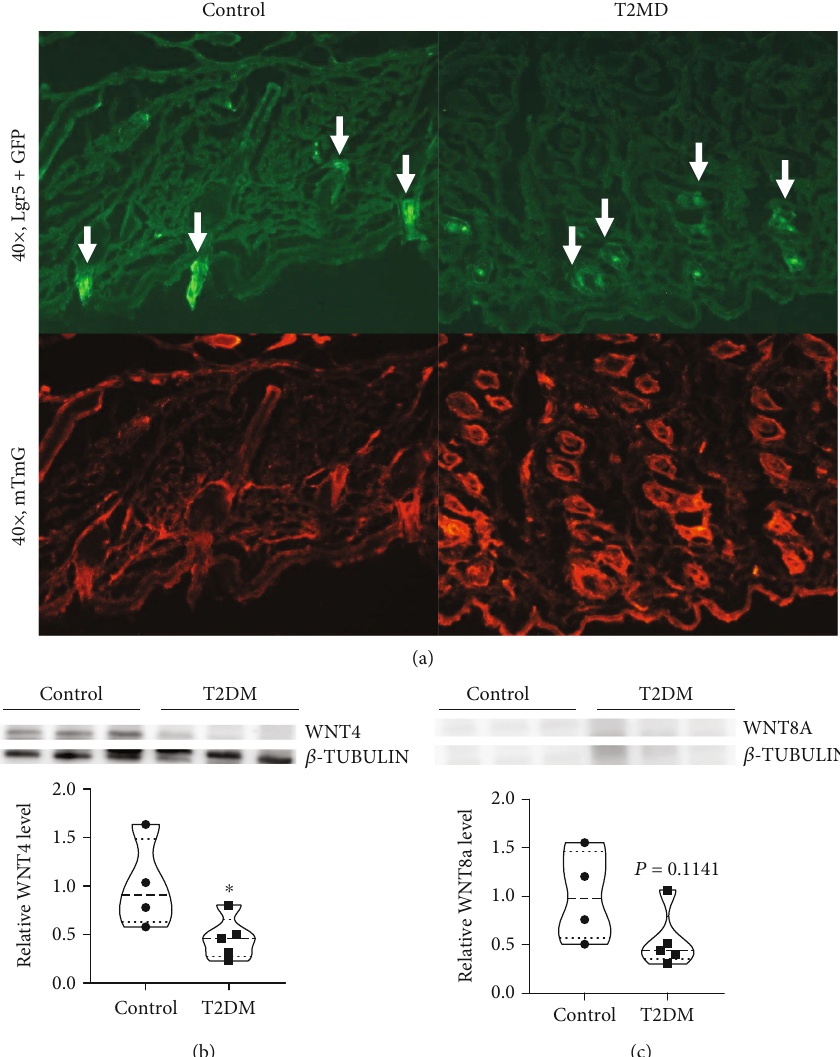
Figure 4: T2DM inhibits Lgr5+ hair follicle stem cells activation and WNT expression. (a) Representative photos of skin sections from Lgr5+ GFP/mTmG mice. (b, c) WNT4 (control 1 ± 0 : 4579 vs. T2DM 0 : 4562 ± 0 : 2201 , P = 0 : 05 , n = 4 − 5 ) and WNT8A (control 1 ± 0 : 4648 vs. T2DM 0 : 5404 ± 0 : 3002 , P = 0 : 1141 , n = 4 − 5 ) protein levels in skin. ∗ P < 0 : 05